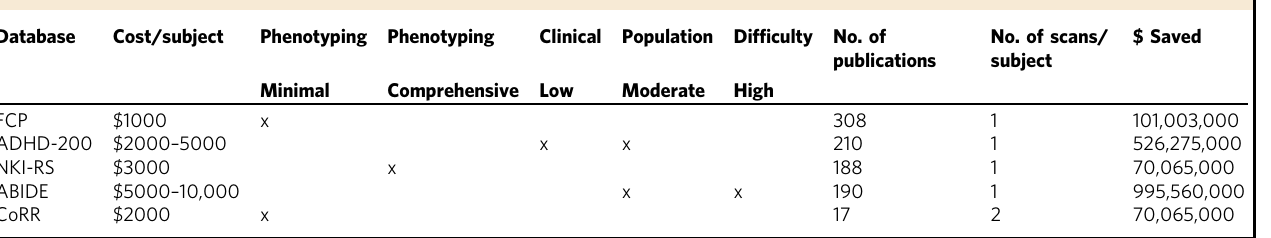
Table 2 Quantifying the money saved through the reuse of